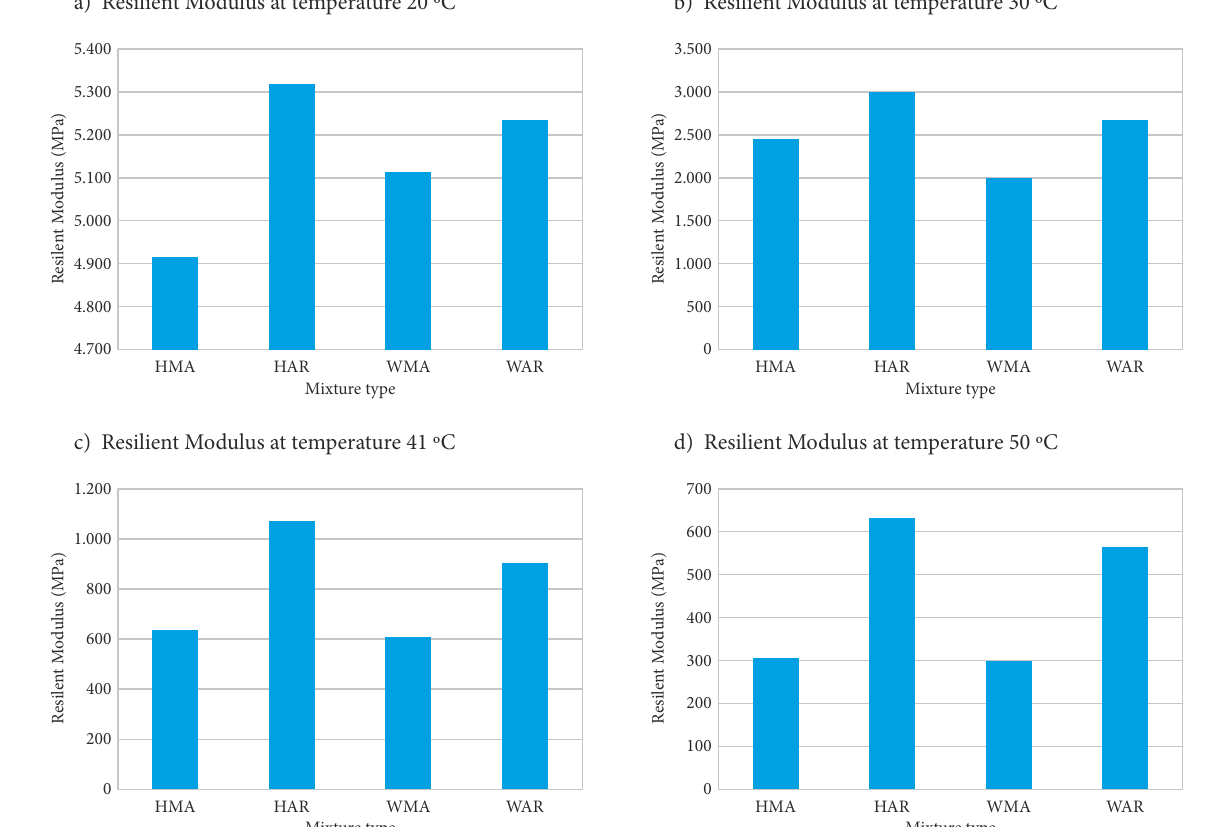
Figure 9. Modulus resilient HMA, WMA, WAR at temperature 20 °C, 30 °C, 41 °C and 50